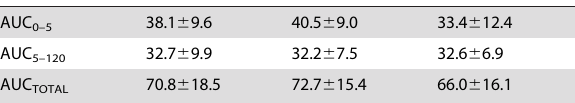
Table 3. Areas under the curve, expressed in SUV, of the peak area (first 5 minutes) and the rest of the arterial input function in the three populations of